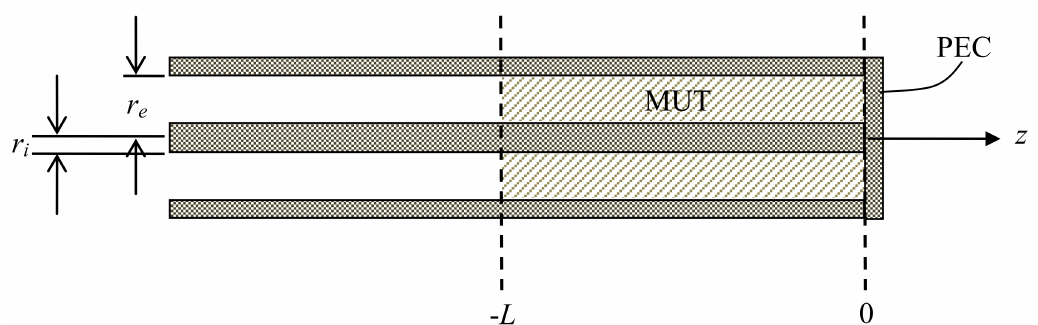
Figure 1. Schematic illustration of the coaxial probe, where the reference system is chosen with the zero at the short, so that the MUT surface occurs at z = − L